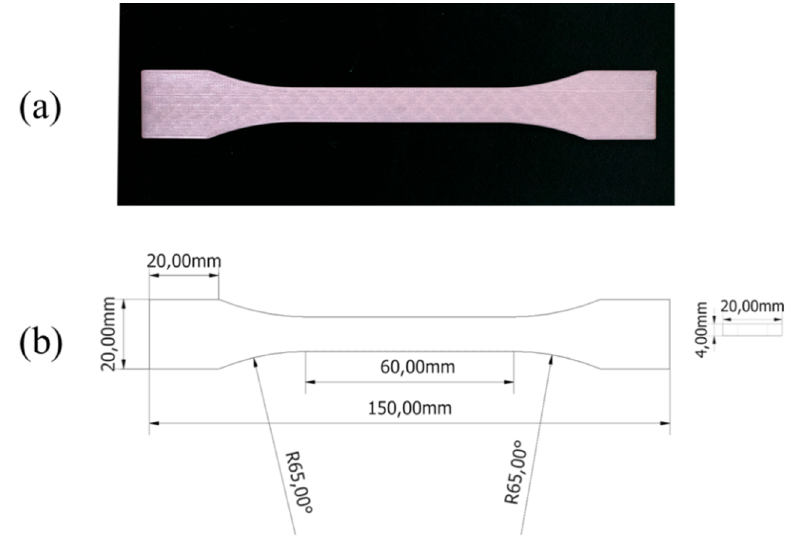
Figure 7. ( a ) Geometry of dog-bone sample; ( b ) The dimension of dog-bone sample.